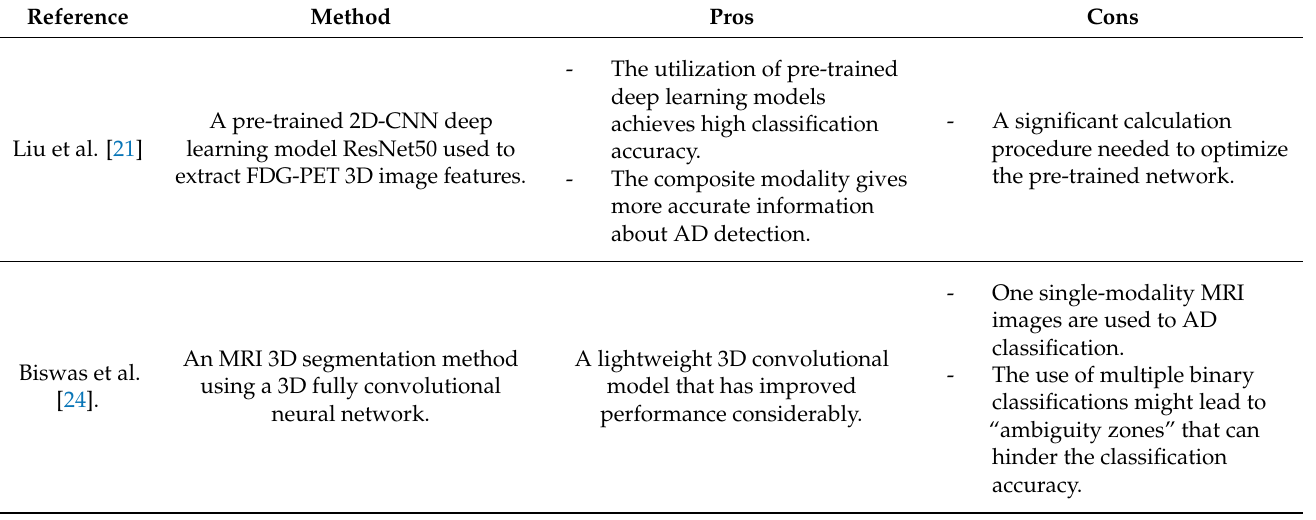
Table 1. Related work